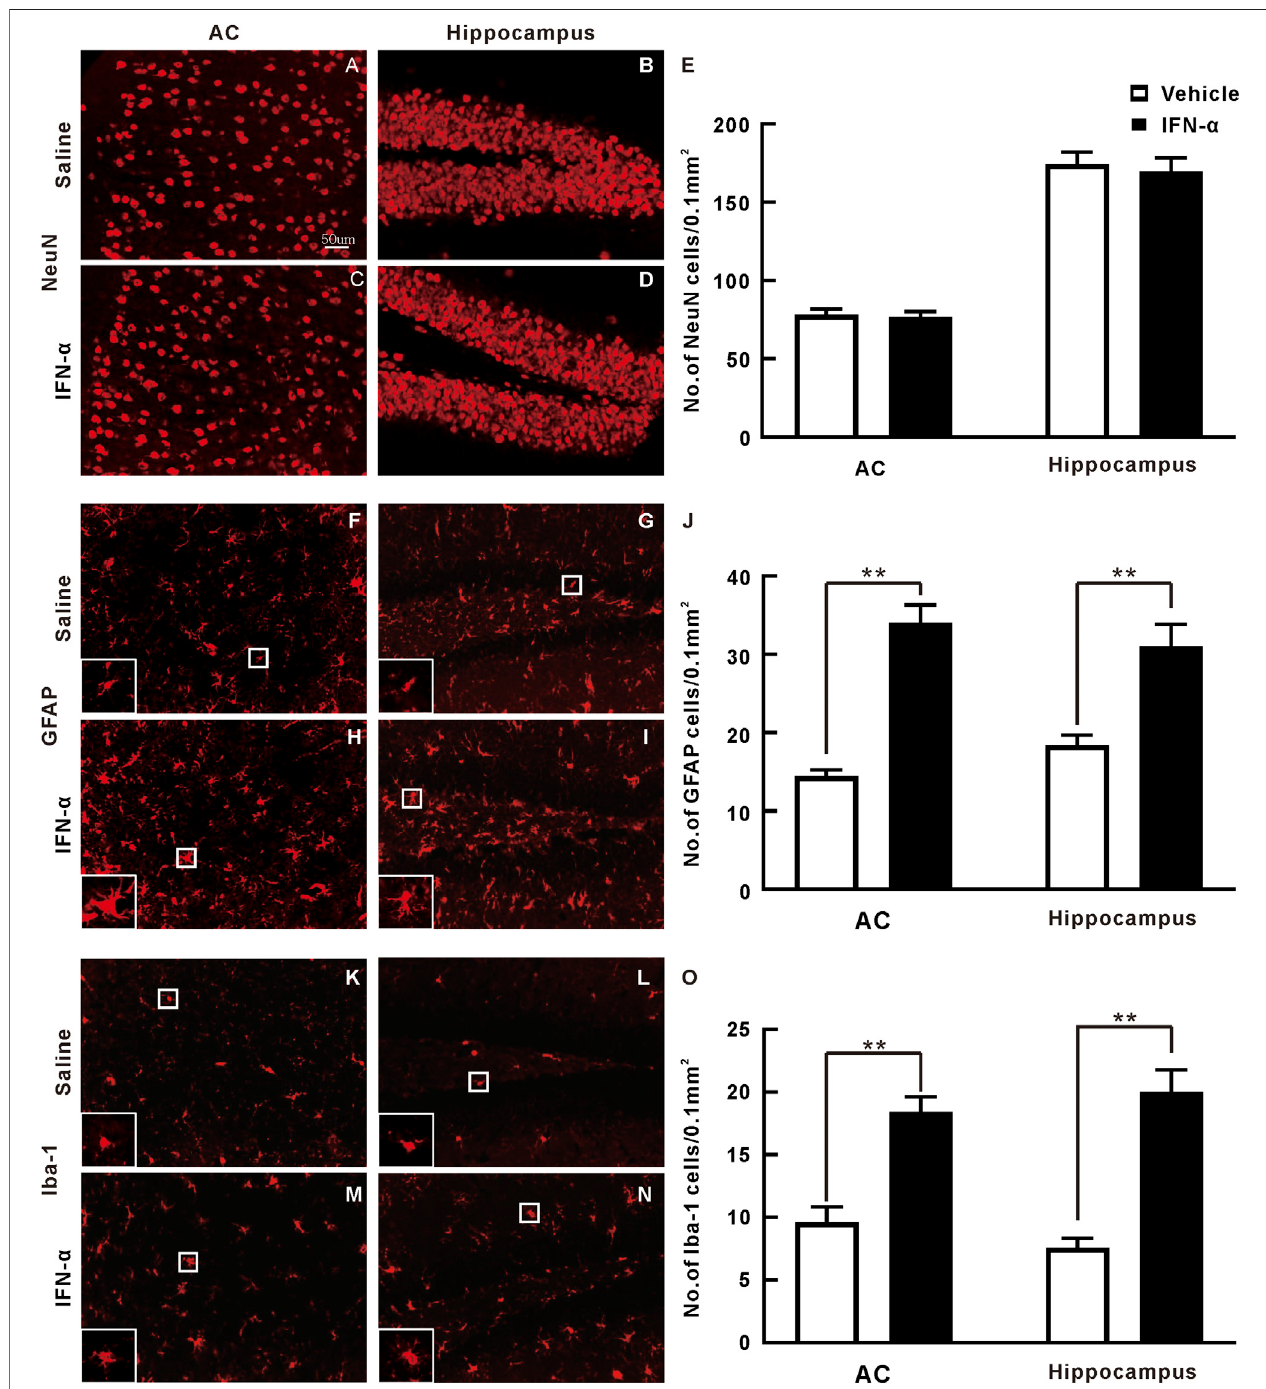
FIGURE6| ImmunohistochemistryanalysisofACandhippocampussectionsafter3weeksofsalineorIFN- α injection. (A) – (D) RepresentativeNeuNstainingofthe AC and hippocampus. (E) Bar graph ofthe density ofNeuNstained cells. Results are expressed asmean ± SE. (F) – (I) Representative GFAP staining. White rectangle is an enlarged view of one representative cell to display the detailed morphology. (J) Bar graph of the density of GFAP stained cells. (K) – (N) Representative Iba-1 staining. (O) Bar graph of the density of Iba-1 stained cells. ** p < 0.01, t -test.